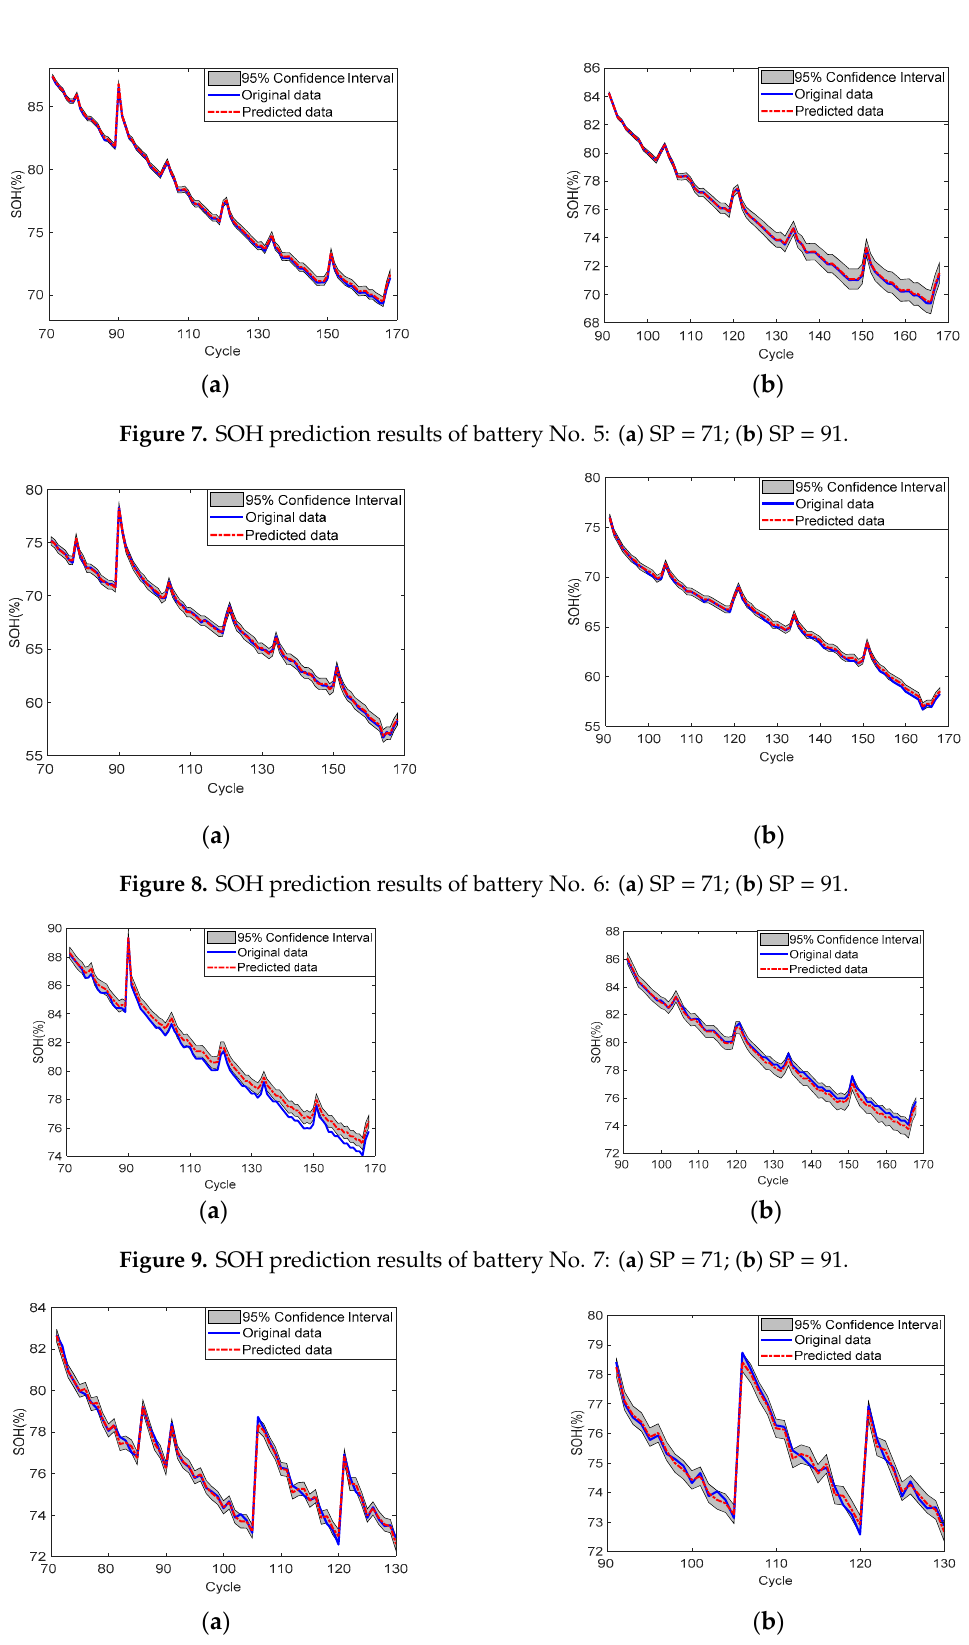
Figure 10. SOH prediction results of battery No. 18: ( a ) SP = 71; ( b ) SP = 91.